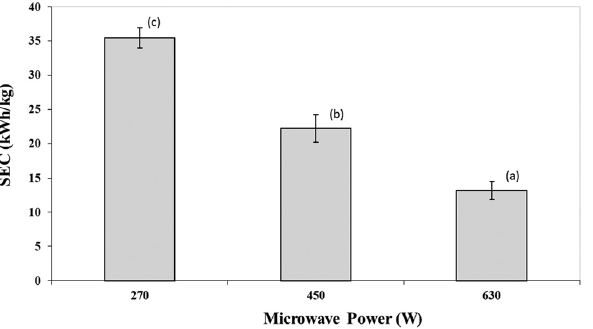
Figure 8: Colour change of dried pomegranate arils in CV dryer. The bars represent mean values and the corresponding standard deviations. Bars with the same letter are not signi fi cantly di ff erent according to ANOVA and Tukey test ( p < 0.05 ) .